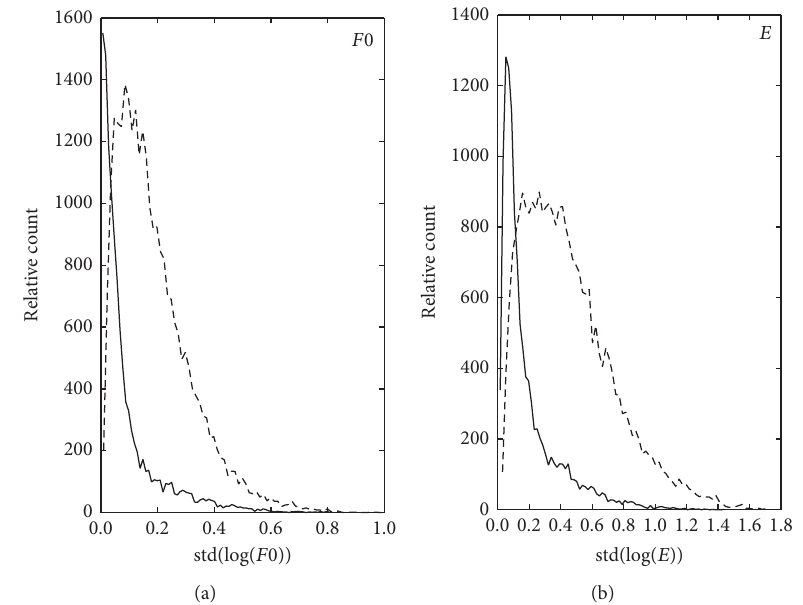
Figure 3: The standard deviation of the logarithms of 𝐹0 (a) and energy (b) of FPs (thick line) and of neighbouring words and phrases (dashed line).